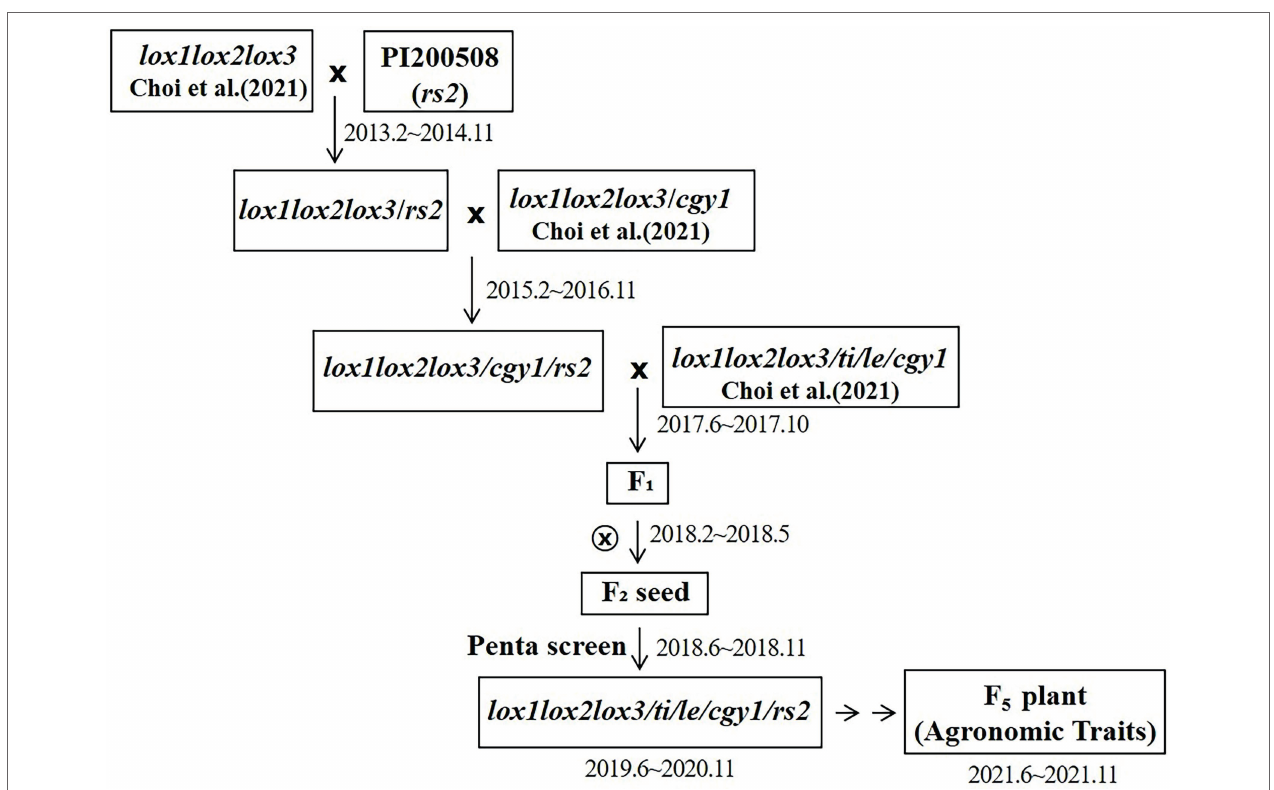
FIGURE 1 | Scheme for the development of penta null alleles ( lox1lox2lox3 / lox1lox2lox3 - ti / ti - le / le - cgy1 / cgy1-rs2rs2 ) for lipoxygenase, KTI, lectin, 7S α ′ subunit and stachyose